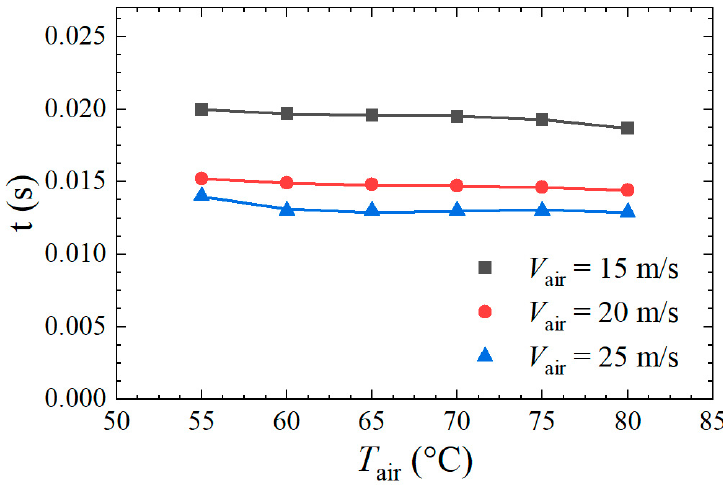
Figure 6. Variation in drying time for water-based inks with airflow temperature. The results indicate that the drying time of water-based ink decreased with the increase in airflow temperature, which is similar to the findings of Avci et al. [10] When T air = 70 ◦ C, it can reduce the drying time of water-based ink as well as decrease heat consumption. The reason for this variation is attributed essentially to the fact that there is a wide difference between the airflow temperature and the initial temperature of the water-based ink. Being influenced by the temperature difference between them, the heat transfer from the hot air to the water-based ink in the initial period of drying raises the temperature of the water- based ink rapidly. After the temperature of the water-based ink increases, its moisture is continuously vaporized.